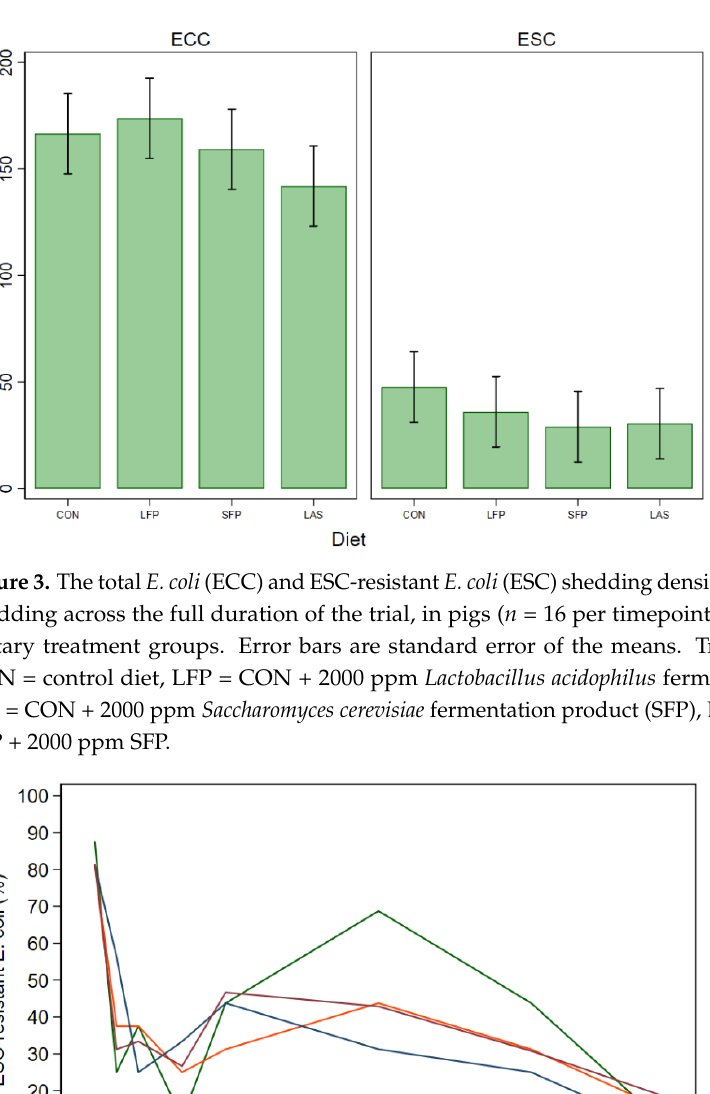
Figure 3. The total E. coli (ECC) and ESC-resistant E. coli (ESC) shedding density, a measure of bac- terial shedding across the full duration of the trial, in pigs ( n = 16 per timepoint) belonging to dif- ferent dietary treatment groups. Error bars are standard error of the means. Treatment abbrevia- tions: CON = control diet, LFP = CON + 2000 ppm Lactobacillus acidophilus fermentation product (LFP), SFP = CON + 2000 ppm Saccharomyces cerevisiae fermentation product (SFP), LAS = CON + 2000 ppm LFP + 2000 ppm SFP.